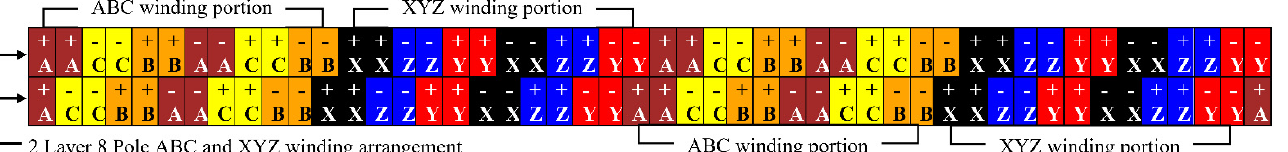
Figure 7. Stator MMF components: ( a ) Fundamental component; ( b ) Sub-harmonic component. Table 1. Design parameters of the proposed SHSM.